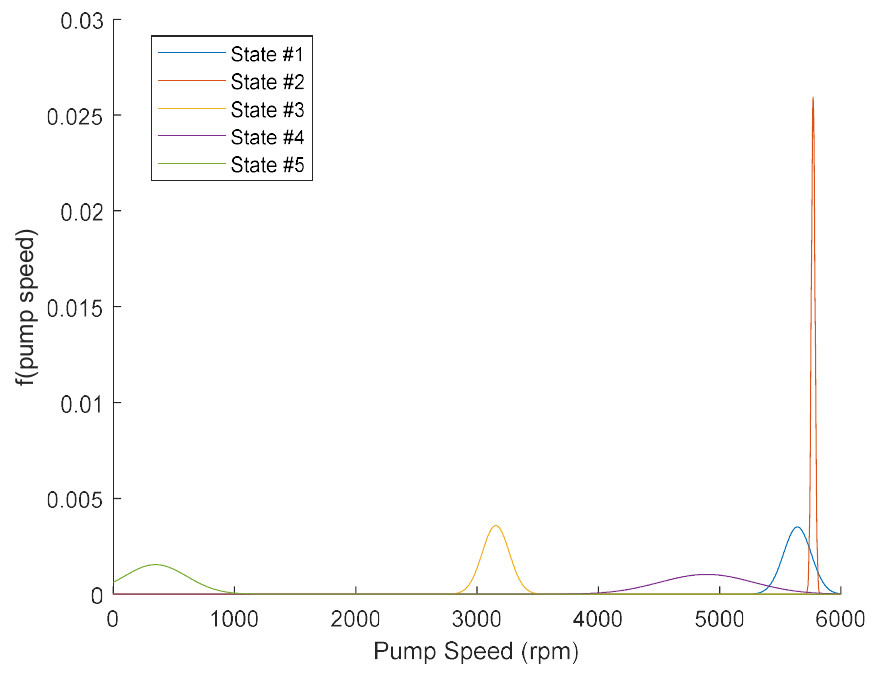
Figure 4. Modes of operational pump speed recovered as Gaussian distributions by a Hidden Markov Model. The five states were determined to be the optimal parameterization by formal model selection methods. States #1 and #2 are normal operations. State #3 is low power refueling.